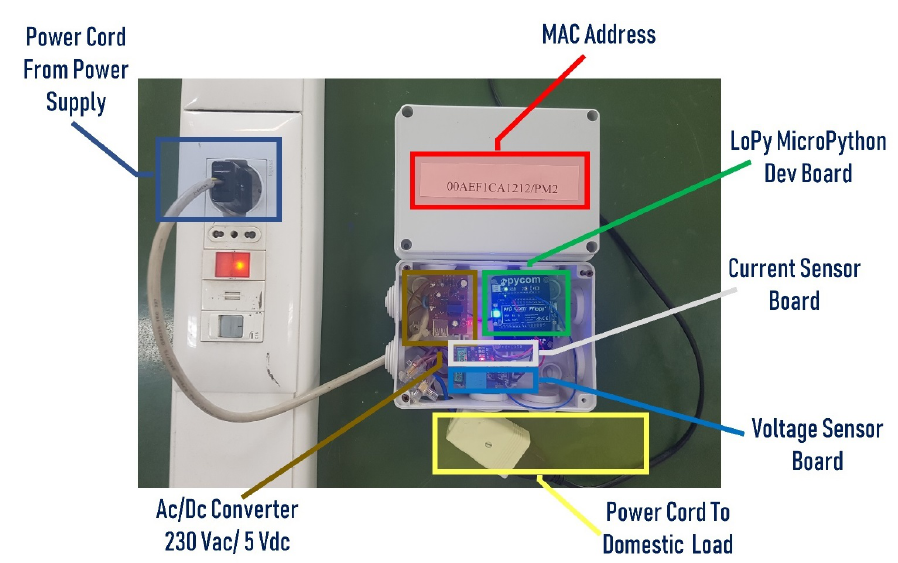
Figure 9. Prototype of sensor node for power measurement of domestic load based on